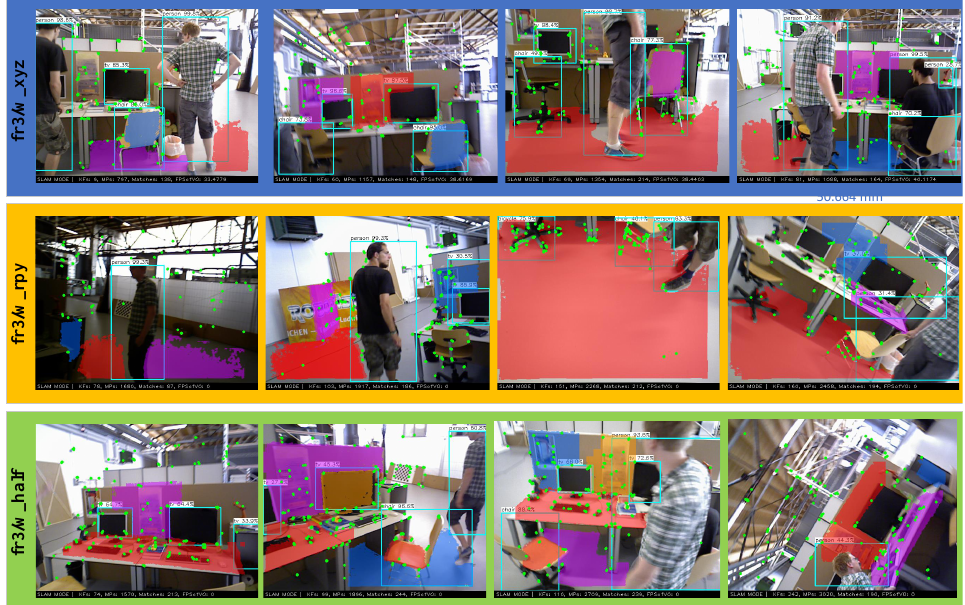
Figure 6. Planar detection, from top to bottom, for the highly dynamic sequences fr3/w_xyz, fr3/w_rpy, and fr3/w_half.